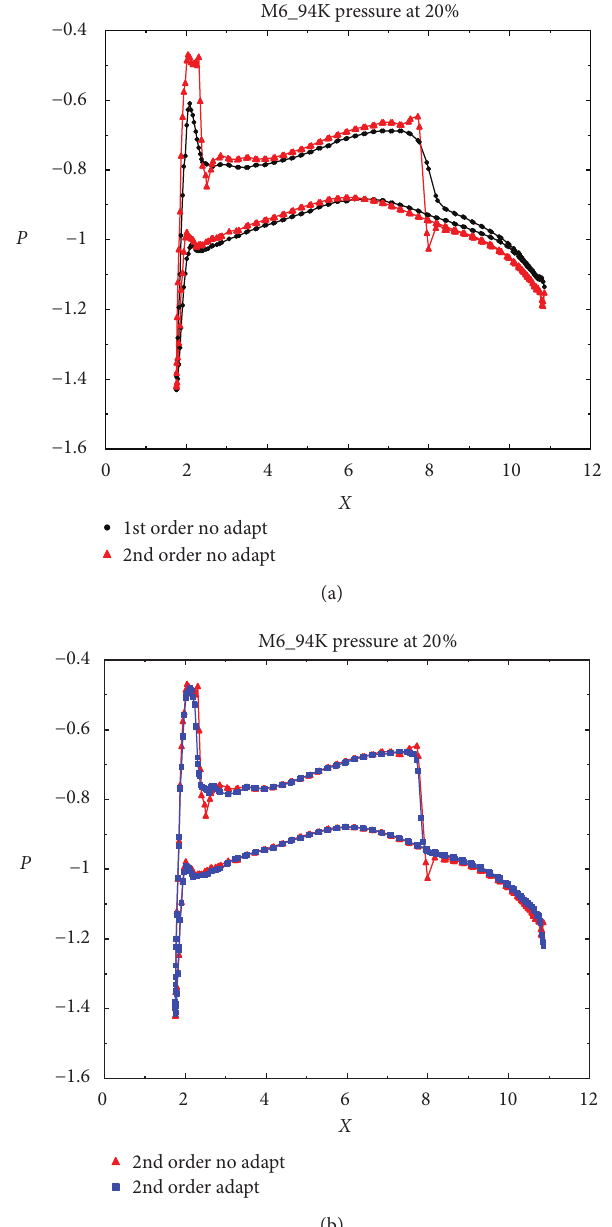
(b) of wing span, using �rst-order and second-order schemes on a nonadapted grid (a), %